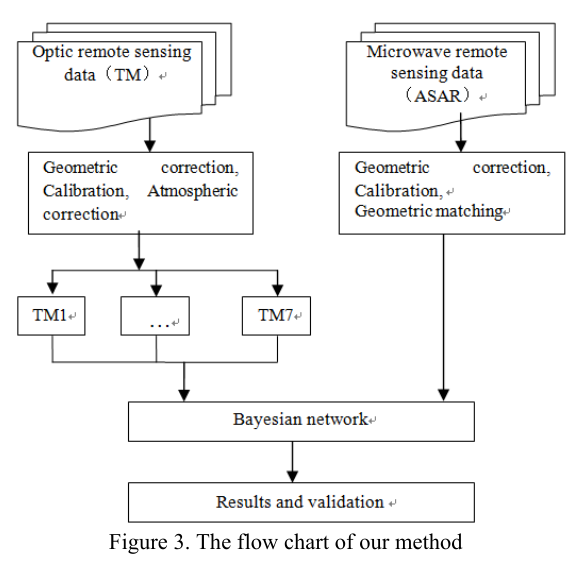
Figure 3. The flow chart of our